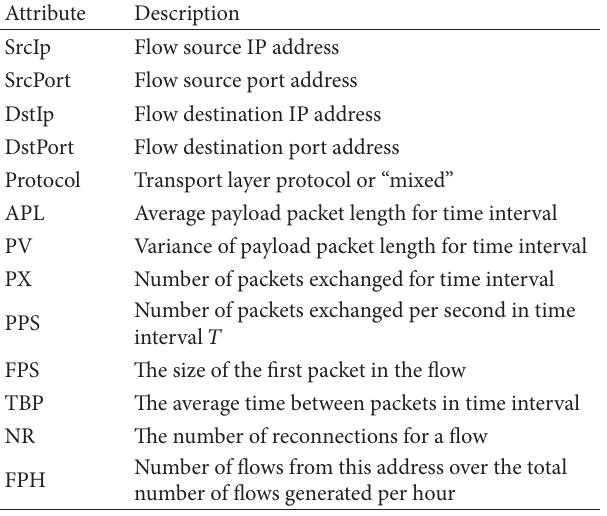
Table 4: Features for flow-based detection comparison.